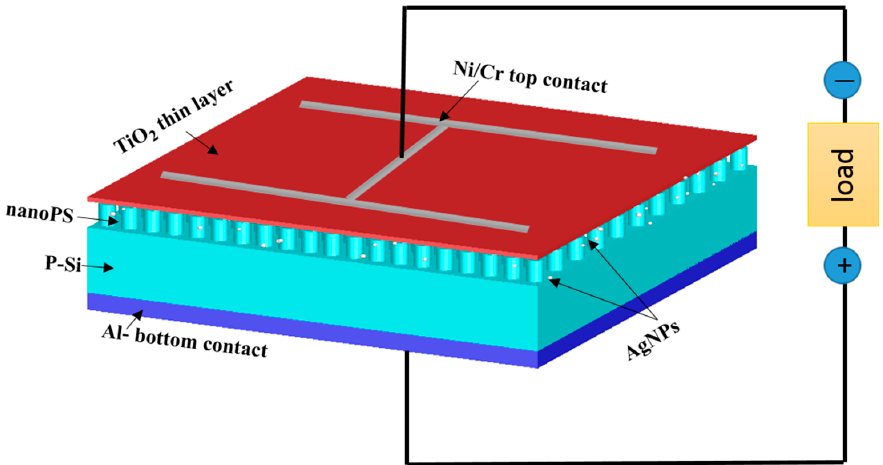
Figure 1. Schematic illustration of the structure of the Al/Si+nanoPS+AgNPs/TiO 2 /NiCr Schottky